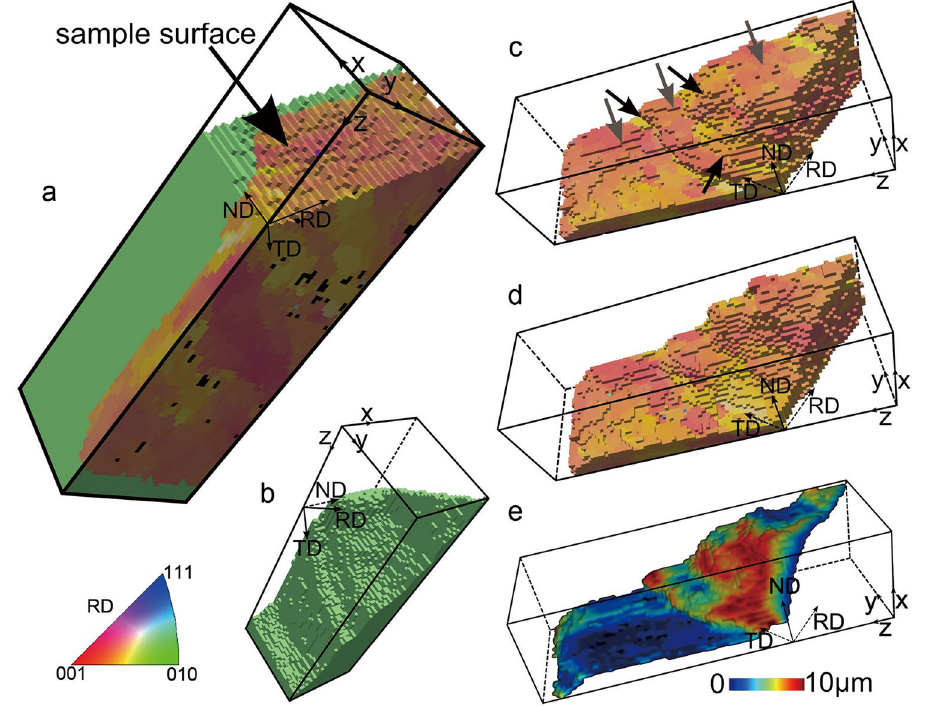
Figure 1. 3D view of the gauge volume mapped by DAXM. ( a ) the whole volume mapped in the initial stage; ( b ) and ( c ) subsets of the volume shown in ( a ) visualizing the recrystallized grain and the deformed matrix, respectively. ( d ) the deformed part of the gauge volume after two annealing steps. The colors in ( a )–( d ) represent crystallographic orientations along the sample rolling direction (RD) (see the color code below ( a )). ( e ) the initial recrystallizing boundary, showing how far each part migrates after the second annealing step (i.e. a plot of the migration distance). The color scale below the figure shows the magnitude of the migration distance. The black voxels in ( a ) represent non-indexed voxels. The dimensions along x, y, z, is 28, 32, 95 µ m, respectively. The gray and black arrows in ( c ) mark faceted and curved parts of the boundary,